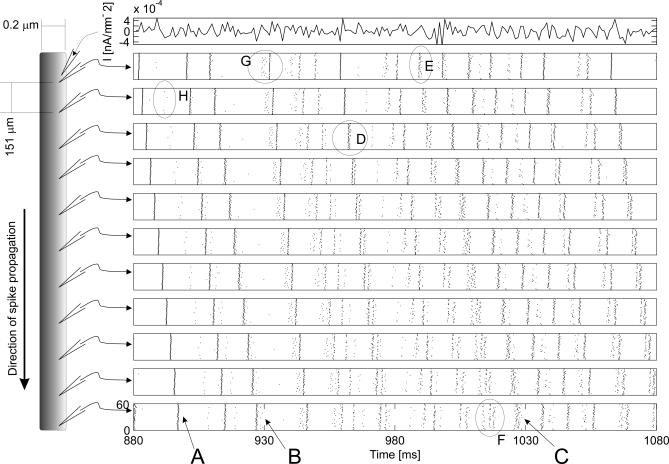
The Stacked Raster Plot Visualizes Traveling APs Produced by Identical Repeated TrialsThe topmost row shows the stimulus current. Below, each row contains a spike raster plot recorded at equally spaced axonal positions (from the proximal stimulus site at the top to the distal part the axon at the bottom). In each spike raster plot, the precise timing of a spike is marked by a dot on an invisible time line. These time lines are stacked over each other for N = 60 repeated trials. The linear shift visible in the overall spike pattern across rows reflects the APs traveling along the axon. Data based on 10-s trials, squid-type axon of 0.2 μm diameter (average diameter of cerebellar parallel fibers). The timing of APs within each set of AP is either unimodal (sets marked by arrows A,B,C), or are markedly multimodal-distributed forming visually distinct groups (set D). In general the timing difference between each group increases as APs travel along the axon (AP sets E and F). APs in a set may be triggered markedly earlier due to differences in the distributions of ion channel states across trials (set G). APs are spontaneously and randomly added (circle H) and in a few cases are even deleted. See text for details.